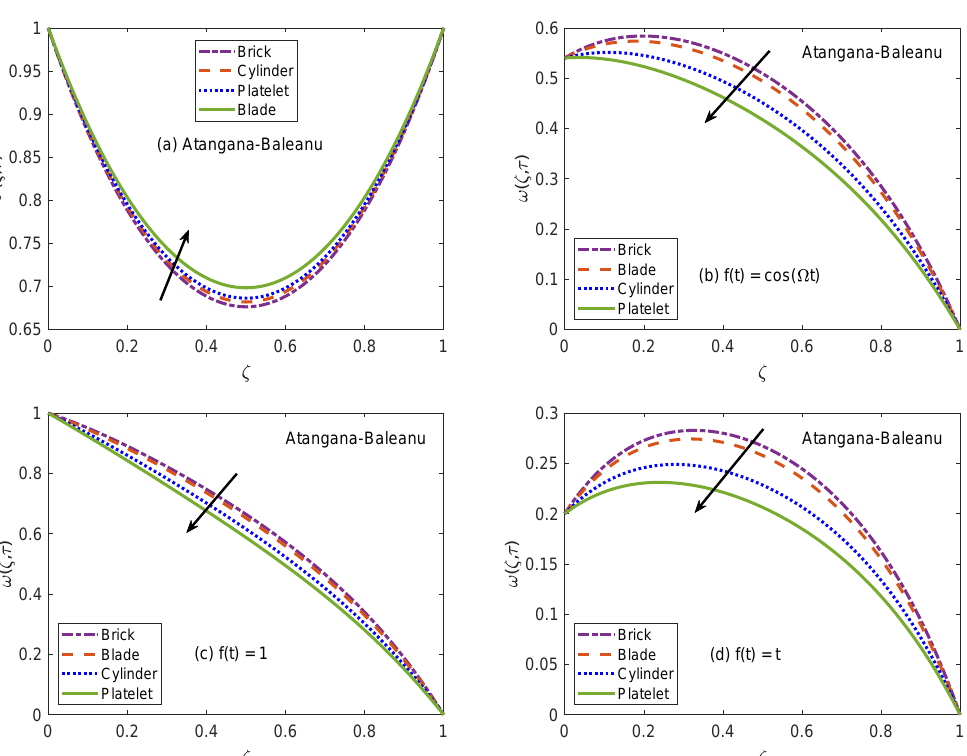
Figure 2. Temperature and velocity patterns of AB model for various shapes of nanoparticles.